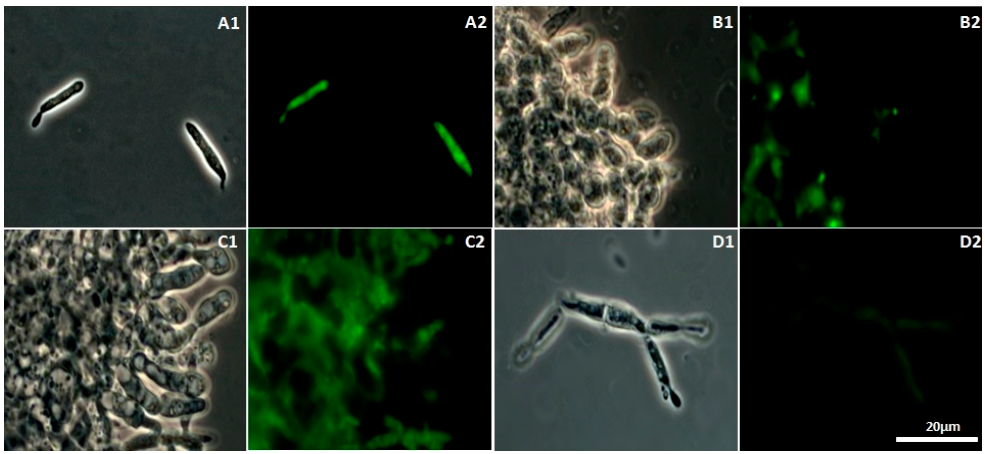
Figure 4. Phase contrast (1) and fluorescence (2) microscopy of U. maydis stained with MitoTracker ® Green FM. An Eclipse E800 fluorescent microscope (Nikon Instruments Inc., Melville, NY, USA) with a fluorescein filter was used. The cells were growth in MM with the different treatment in a concentration of 1 mg mL − 1 . The intensity of the signal is according with the presence of the mitochondrial proteins. A = Control; B = Chitosan; C = Oligochitosan; D = Glycol-chitosan. Time of incubation of 24 h.